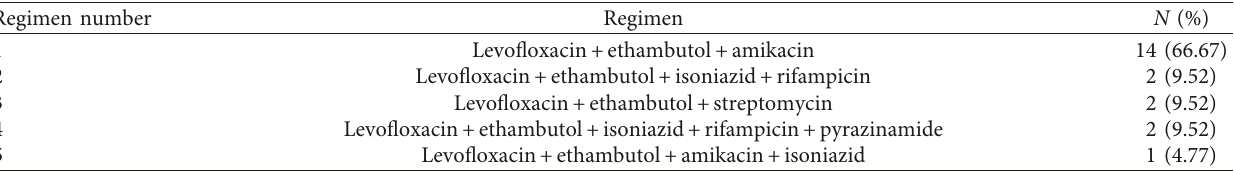
Table 2: The levofloxacin-based regimens that were prescribed as empirical therapy for patients before the diagnosis of tuberculosis. ( N � 21).